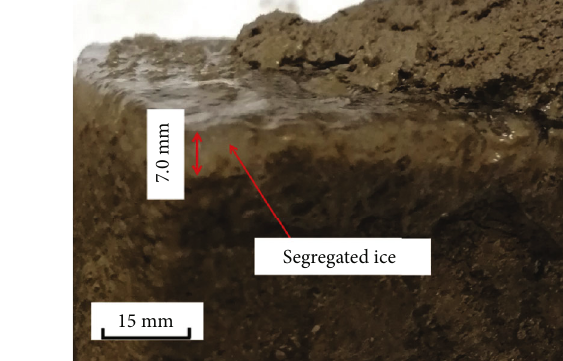
Figure 15: The soil column segregation crack phenomenon.